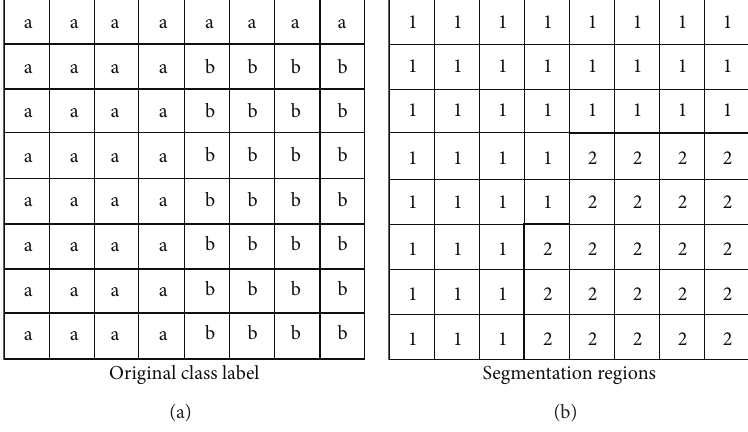
Figure 3: Mapping mechanism by the area dominant principle.